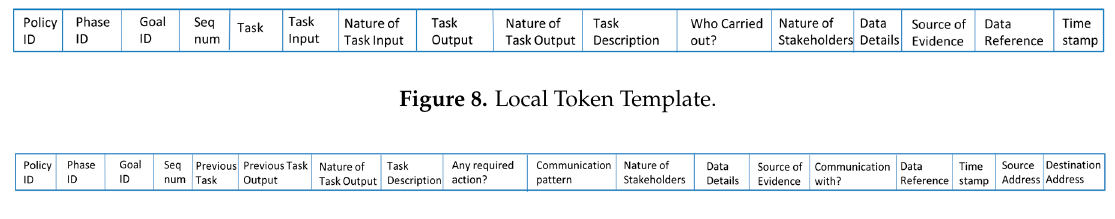
Figure 9. Token Structure.